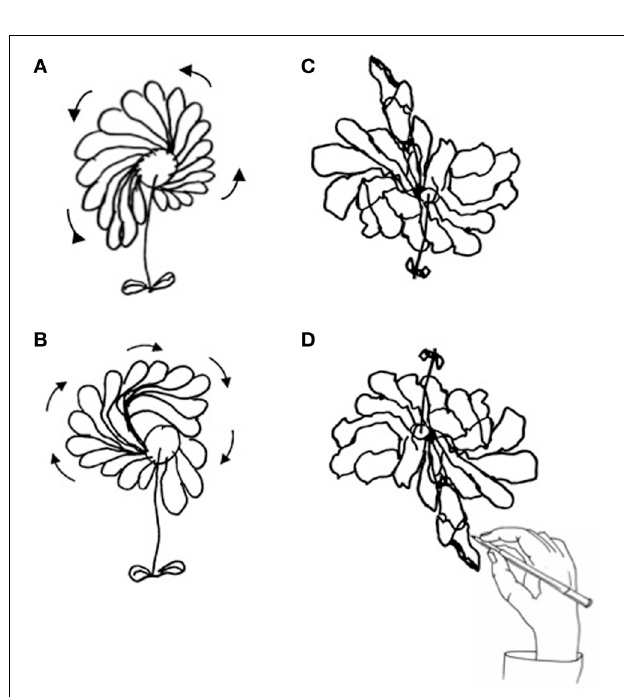
FIGURE 3 | Drawing of daisy from memory by P#1: in the clockwise direction (A), in counter-clockwise direction (B), and in the epidiascope condition [daisy seen (C), daisy drawn